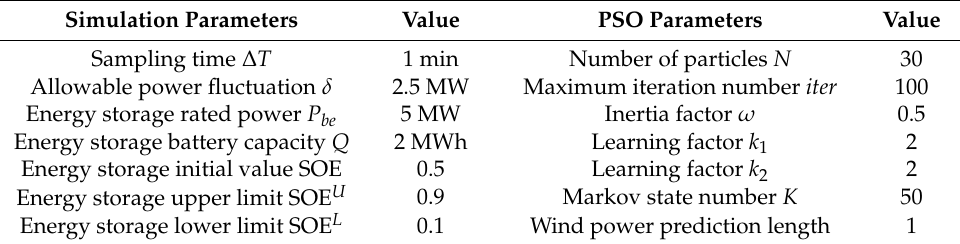
Table 2. Simulation parameters.